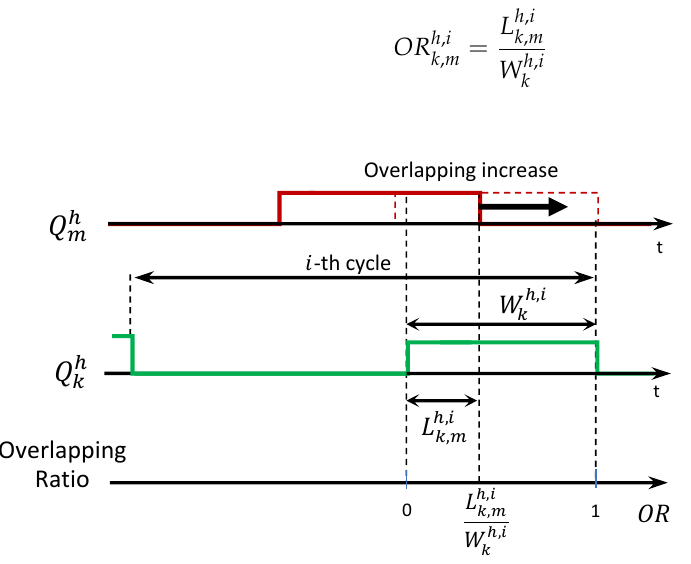
Figure 4. Overlapping configuration between two TT windows with different priority queues.